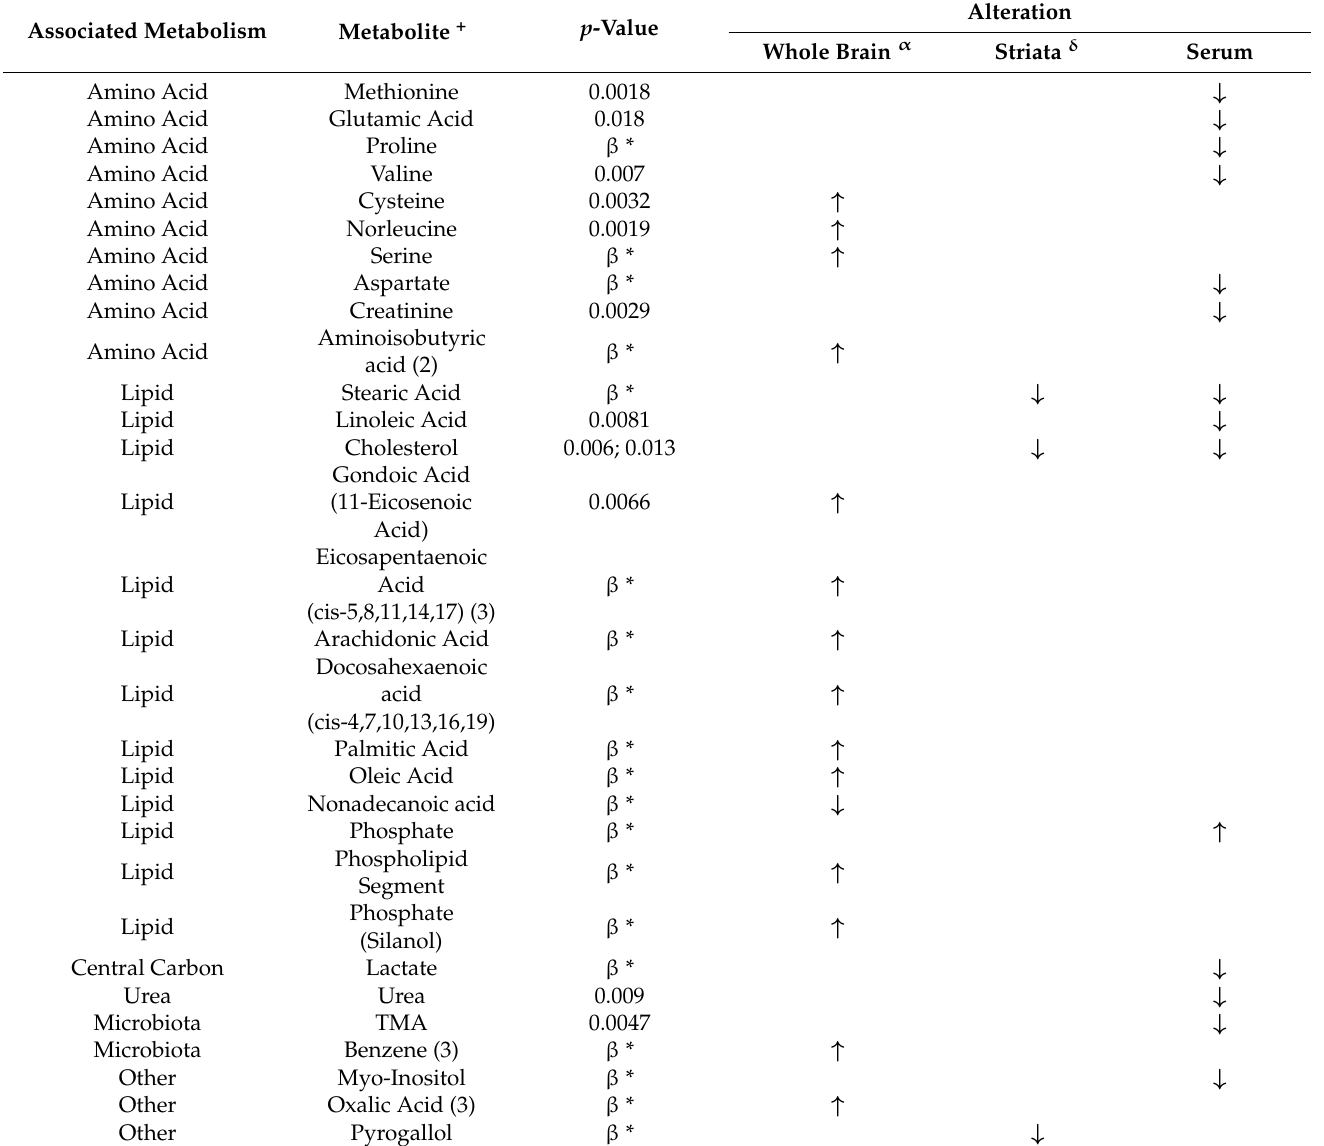
Table 2. KW-6002 metabolic alterations in serum and brain samples ‡